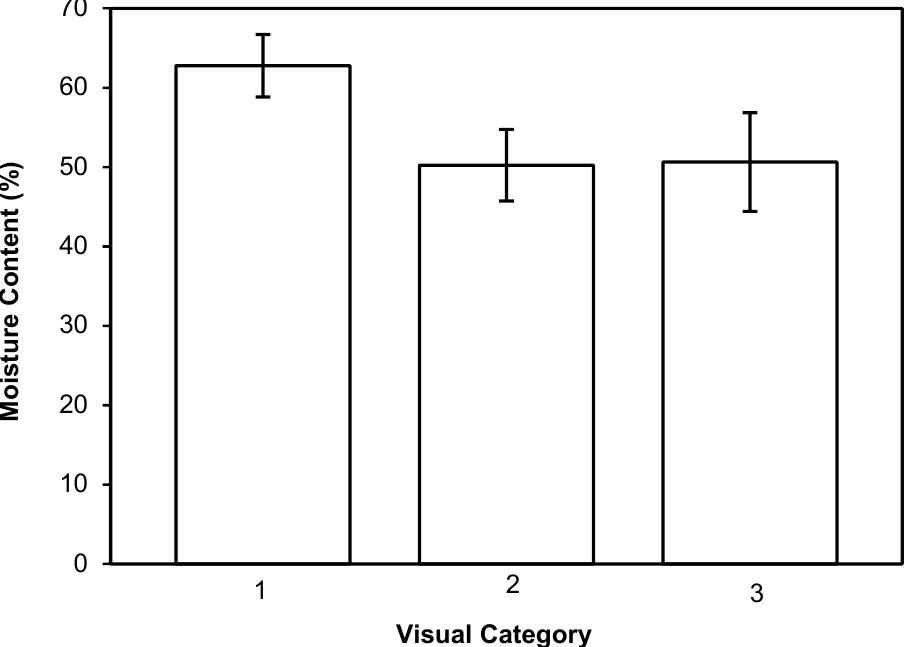
Figure 4. Mean moisture content (% by oven-dry weight) by visual category. Error bars represent the 95% confidence interval.